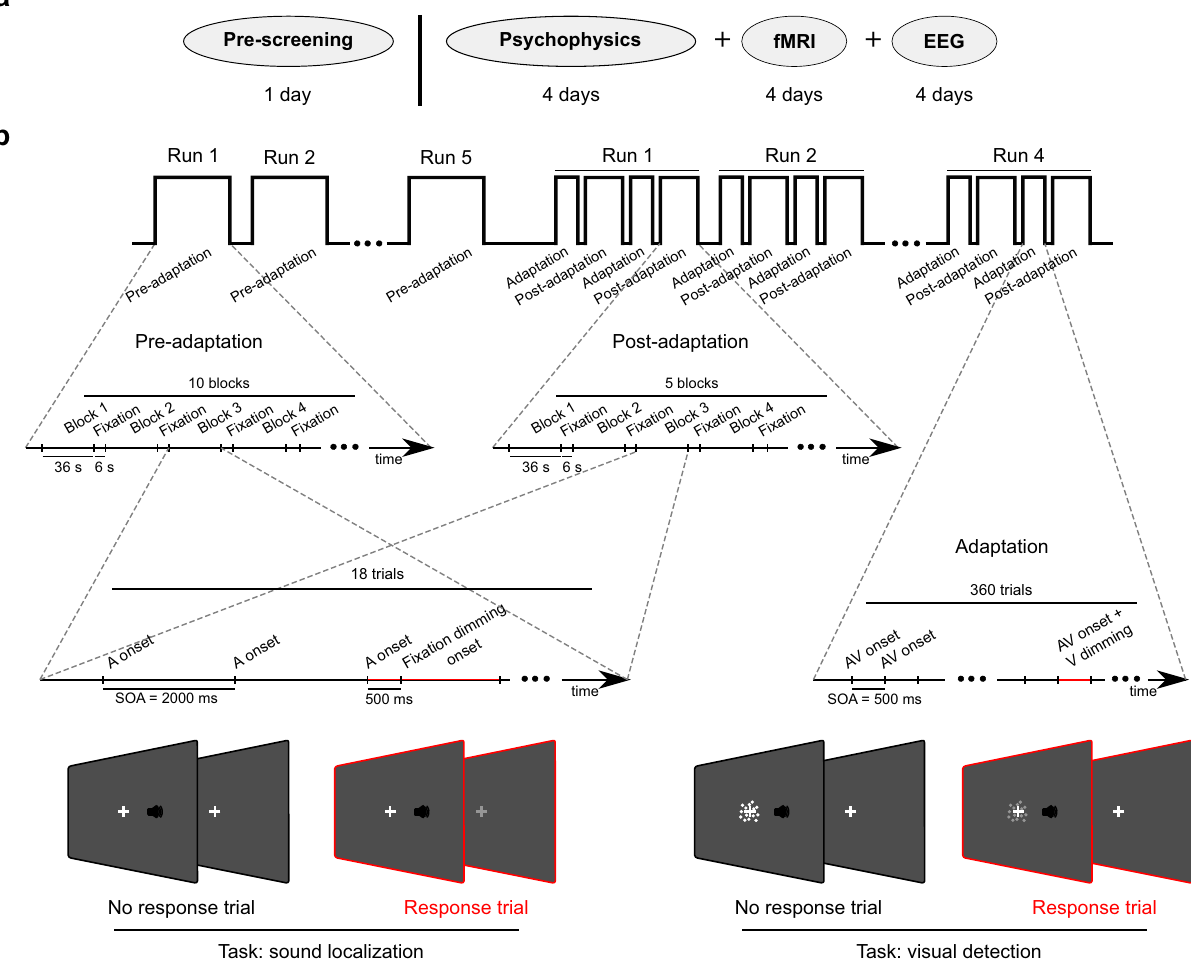
Fig. 1 Study and experimental design. a The study included one day of pre-screening, 4 days of psychophysics testing, 4 days of fMRI and 4 days of EEG. b Each day included (i) auditory pre-adaptation, (ii) left (i.e. VA) or right (AV) audiovisual adaptation and (iii) auditory post-adaptation phases. In the pre- adaptation and post-adaptation phases, observers were presented with unisensory auditory stimuli sampled from seven (±12°, ±5°, ±2° and 0° visual angle) locations along the azimuth. They performed a spatial (left vs. right) classi fi cation task on 22% of the trials ( ‘ response trial ’ ) that were indicated by a brief dimming of the fi xation cross 500 ms after sound onset. In the audiovisual adaptation phases, observers were presented with audiovisual stimuli with a spatial disparity of ±15°: the visual signal was sampled from three locations along the horizontal plane (i.e. − 5°, 0° and 5°) and the visual signal was spatially shifted by 15° either to the left (i.e. VA-adaptation) or to the right (i.e. AV-adaptation) with respect to the auditory stimulus. Observers were engaged in a non-spatial visual detection task on 10% of the trials ( ‘ response-trial ’ ) indicated by the lower contrast of the visual signals. Each day started with the pre-adaptation phase. Next, VA (or AV) adaptation phases alternated with postVA (or postAV) adaptation phases. This fi gure shows the experimental details for the fMRI experiments, which were slightly modi fi ed for EEG and psychophysics experiments (for details see Experimental design and procedure